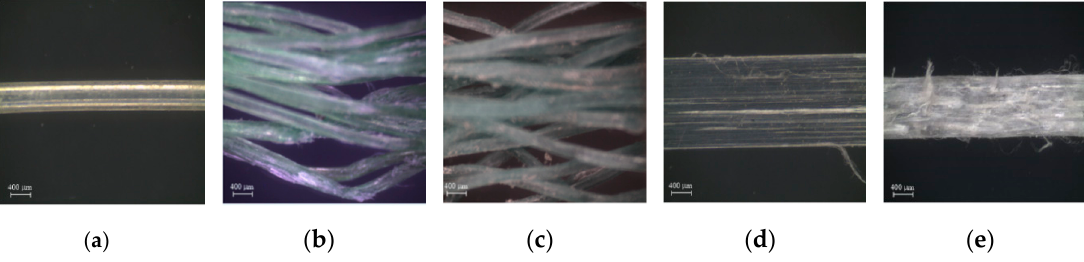
Figure 10. Surfaces of the macro-fibers after the pullout testing: ( a ) WFN1; ( b ) WFN2; ( c ) WFN3; ( d ) CP1; ( e ) CP2.